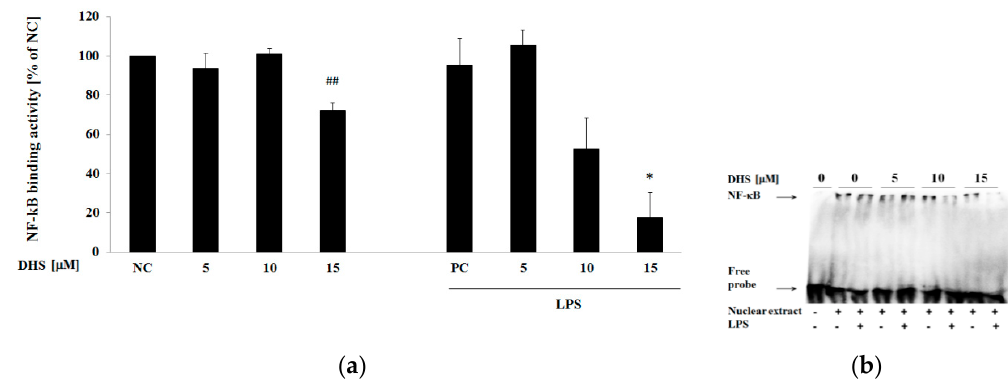
Figure 7. Effect of DHS on NF- κ B binding activity performed by EMSA using nuclear extracts of NHDF treated with 5–15 µ M DHS for 6 h or in the presence of LPS. ( a ) Graphical presentation of the results, where NF- κ B binding activity is expressed as mean percentage relative to NC ± SEM ( n = 3), significantly different from NC ( ## p < 0.01) or PC (* p < 0.05). NC: negative control (0.1% vehicle DMSO in serum-free culture medium), PC: positive control (6 h of LPS stimulation with 0.1% vehicle DMSO in serum-free culture medium). Quantification was performed by densitometric analysis of bands. ( b ) Representative gel image.